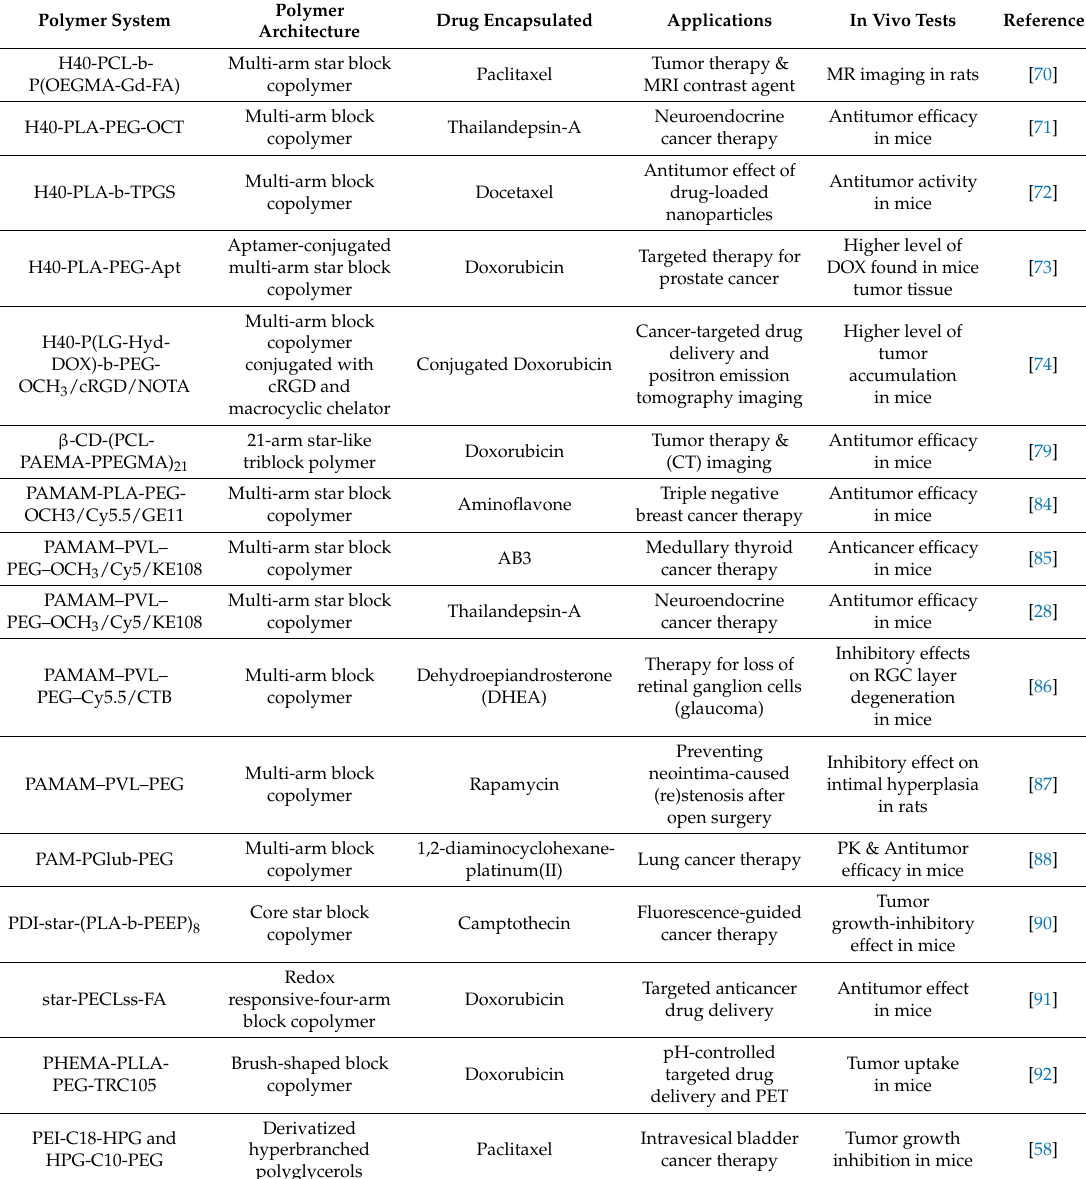
Table 1. Unimolecular micellar systems used for in vivo drug